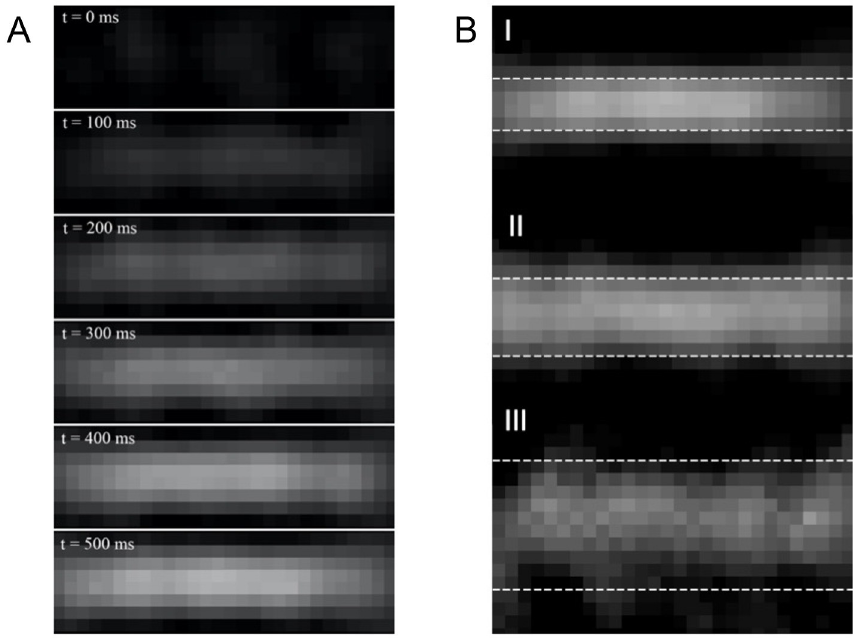
Fig 4. MPI-visualized bolus inflow. (A): MPI images of the bolus inflow in a glass tube with a 4 mm inner diameter in time steps of 100 ms. At first, only background noise is present. Subsequently, a line shaped central signal fades in, which saturates after a short period of time until a maximum is reached . (B) : Comparison of the bolus intensity peak between all three glass tubes at a velocity of 0.51 m/s. The dotted lines represent the presumable locations of the glass tube edges. The bolus of the (I) 4 mm inner diameter glass tube appears well-defined and more evenly distributed compared to the ones of the (II) 6 and (III) 10 mm inner diameter glass tube. With increasing diameter of the glass tube, the bolus becomes progressively inhomogeneous and the edges become more difficult to